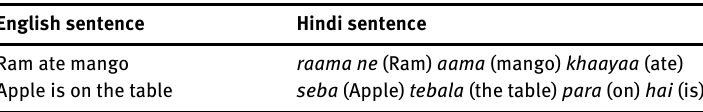
Table 1: Example of Different Word Orders in English and Hindi.